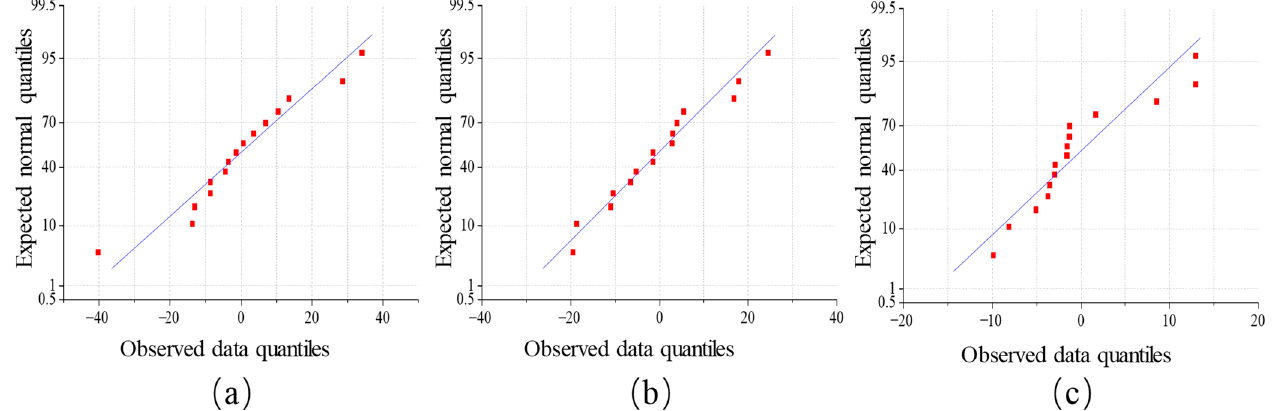
Figure 9. The quantile ‒ quantile plots of ( a ) soil sand, ( b ) silt, and ( c ) clay content.